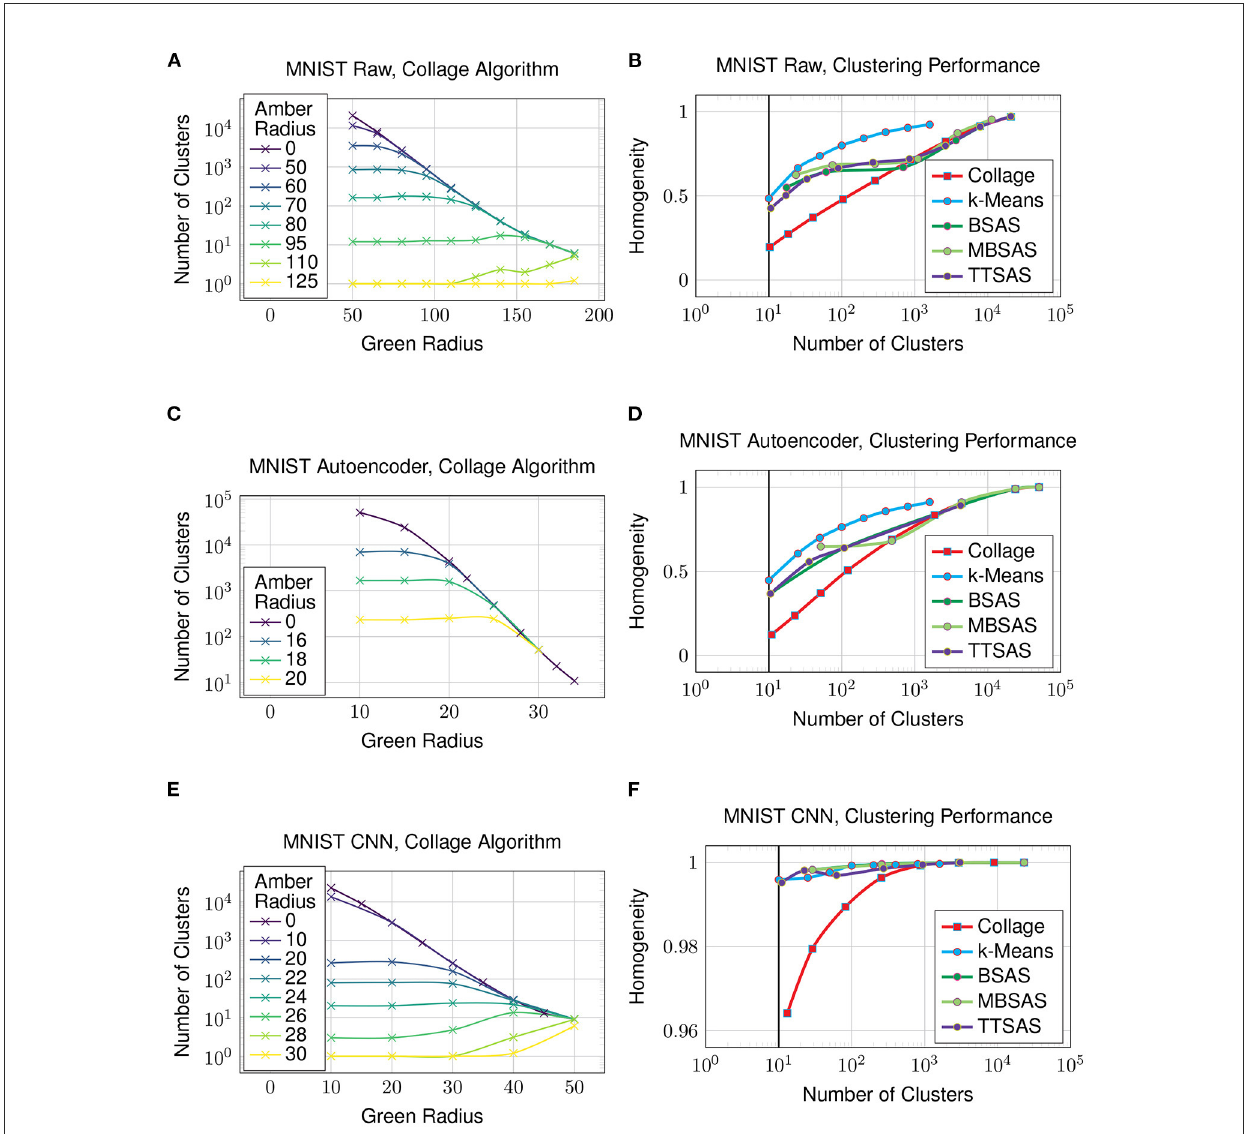
FIGURE7 Clustering on the MNIST dataset. Solid vertical line in (B, D, F) denotes the case where clusters obtained is equal to number of ground truth classes. (A) MNIST raw, collage algorithm, (B) MNIST raw, clustering performance, (C) MNIST autoencoder, collage algorithm, (D) MNIST autoencoder, clustering performance, (E) MNIST CNN, collage algorithm, and (F) MNIST CNN, clustering